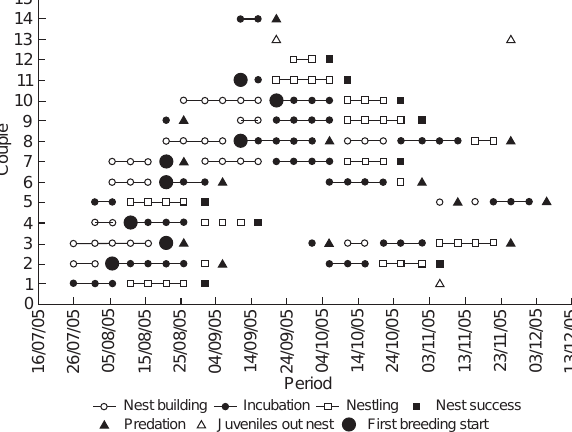
Figure 2. Reproductive stages of P. superciliaris in 2005 in the Parque Estadual da Serra do Rola Moça, Minas Gerais,